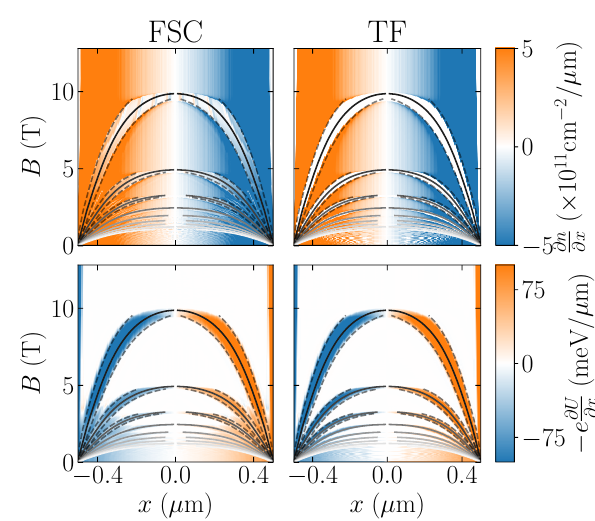
Figure 10: Gradient of the density (top) and potential (bottom) as a function of the = − 0.75V for the geometry of Fig. 1(b). Left panel: FSC, right magnetic field B at V g panels: Thomas-Fermi. The black lines correspond to the theoretical estimate for x ν while the dashed lines correspond to x ν ± δ x ν / 2 for the first three Landau levels ν =